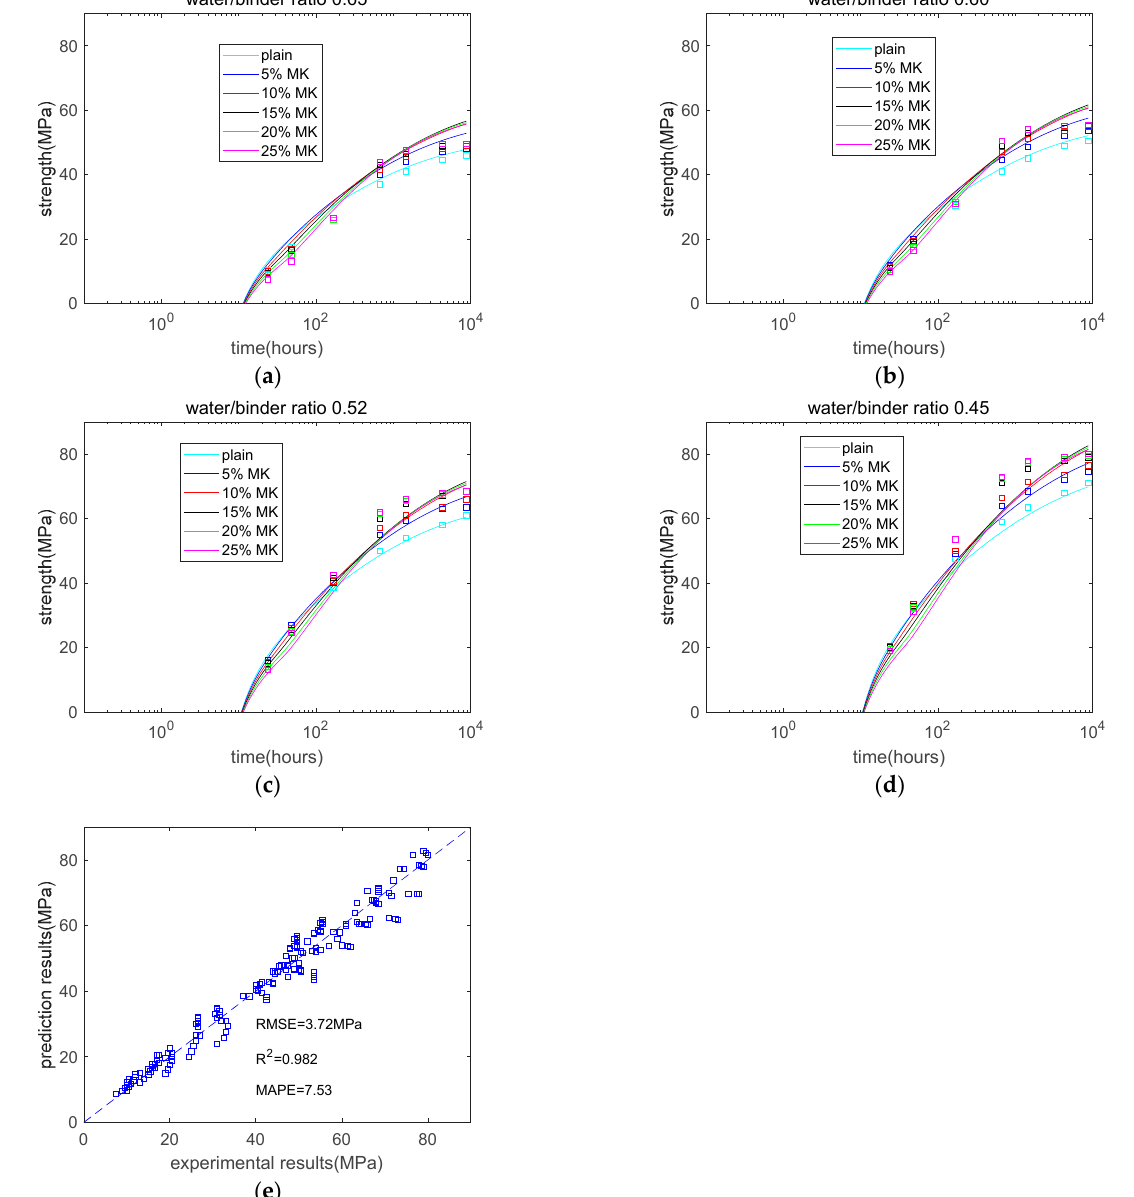
Figure 4. Evaluation of the strength of concrete. ( a ) water/binder ratio 0.65. ( b ) water/binder ratio 0.60. ( c ) water/binder ratio 0.52. ( d ) water/binder ratio 0.45. ( e ) experiment versus prediction results.